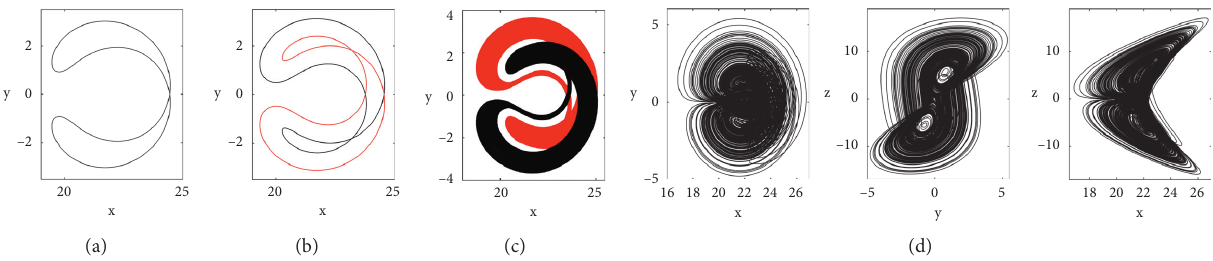
Figure 3: Phase planes of SynRM without external inputs for a specific value of parameter a : (a) a � 1 . 5, (b) a � 1 . 8, (c) a � 2, and (d) a � 3. The curves in black line are obtained by using the initial conditions ( x ( 0 ) , y ( 0 ) ,z ( 0 )) � ( 0 . 1 , 0 . 2 , 0 . 2 ) , while the curves in red line are obtained by using the initial conditions ( x ( 0 ) , y ( 0 ) ,z ( 0 )) � ( 0 . 1 , − 0 . 2 , − 0 . 2 ) . The remaining parameters are b � 0 . 2 and c �